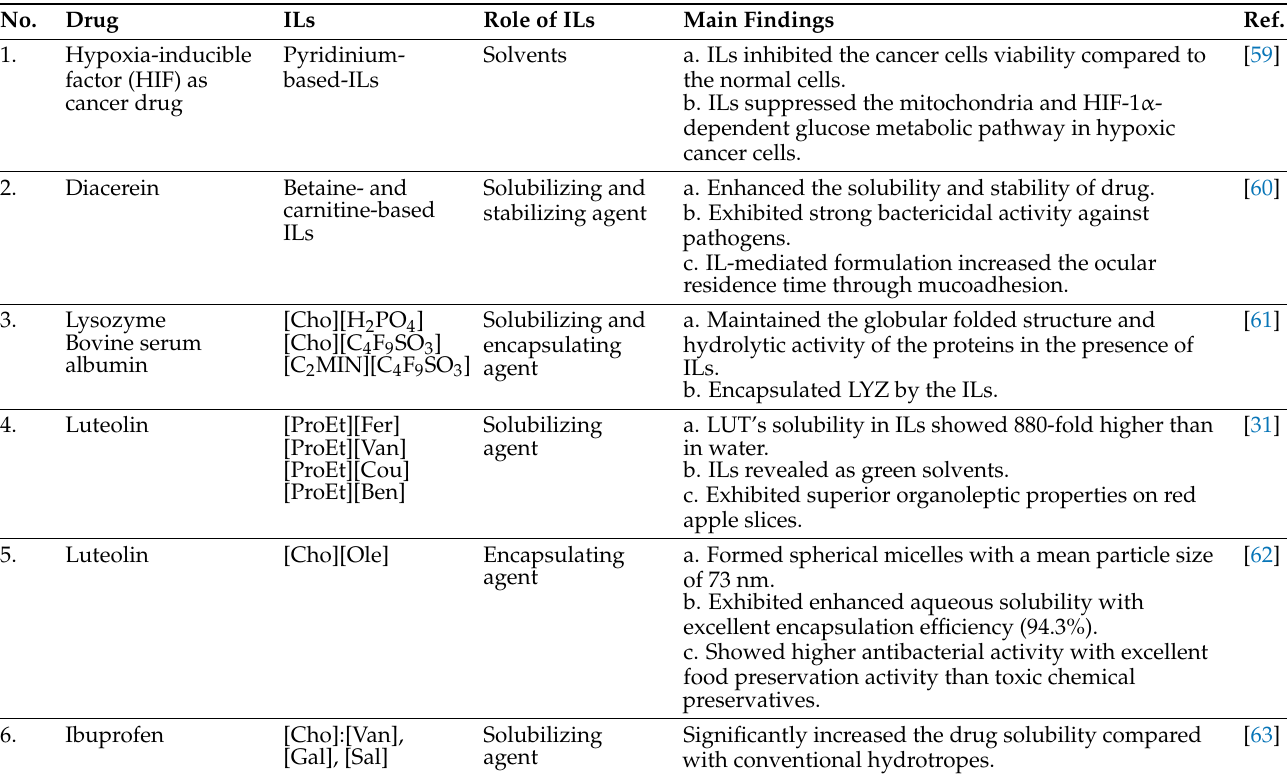
Table 1. Pharmaceutical applications of Bio-ILs as solvents, solubilizing and encapsulating agents, stabilizers and